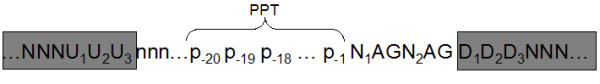
Nomenclature of features used in this study. Nomenclature of sequence features used to analyze NAGNAG splicing. The region used to derive all 31 features is shown, along with the names given to the positional features.